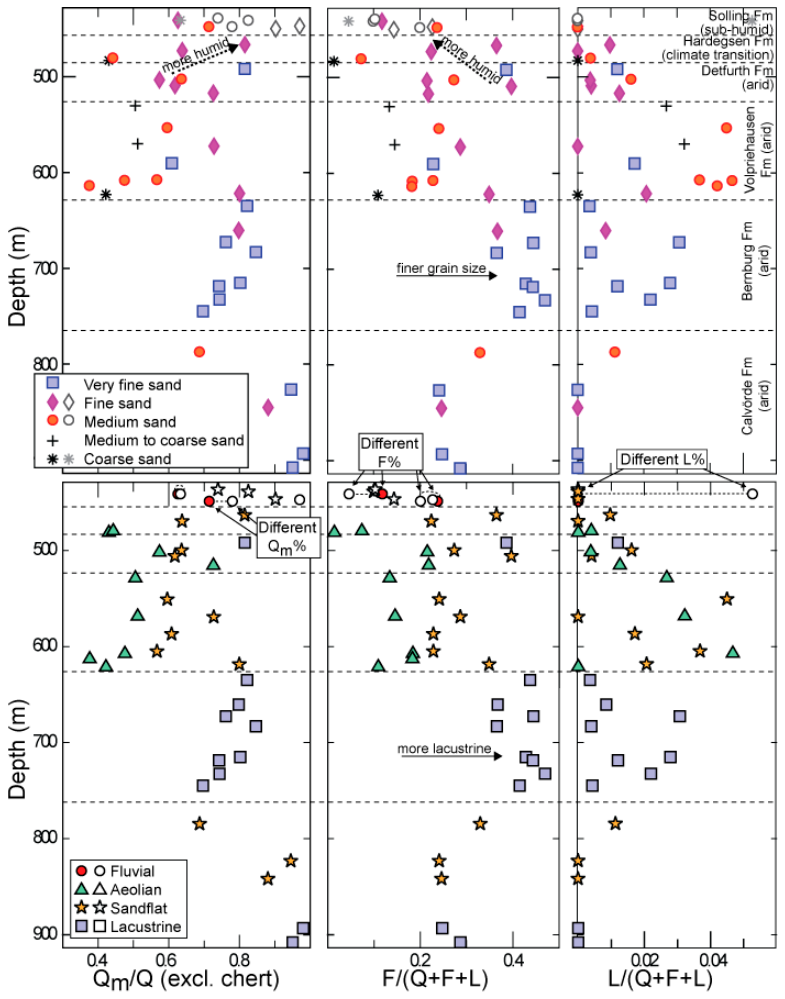
Figure 3. Compositional trends for Early Triassic sandstone in well Rockensußra 2/83 (Germany) based on data from Beyer [39] (coloured symbols) and Augustsson et al. [20] (white and grey symbols). Trends vs. both grain size and facies are shown. Identical samples are connected with dotted lines. Note that one sample was estimated as fine sandstone (200 µm) by Beyer [39], but coarse sandstone by Augustsson et al. [20]. F: feldspar; L: lithic/rock fragments (poly-mineralic grains only; no carbonate clasts were detected); Q: quartz (both monocrystalline and polycrystalline grains); Q m : monocrystalline Q.